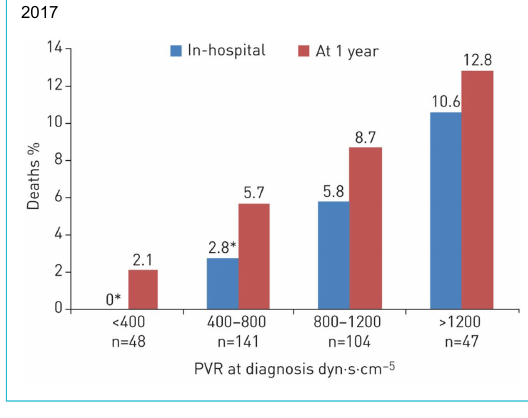
Figure 15: Effects of pulmonary vascular resistance (PVR) at diag- nosis on in-hospital and 1-year mortality in patients with chronic thromboembolic pulmonary hypertension (CTEPH) undergoing pulmonary endarterectomy. Data from the international